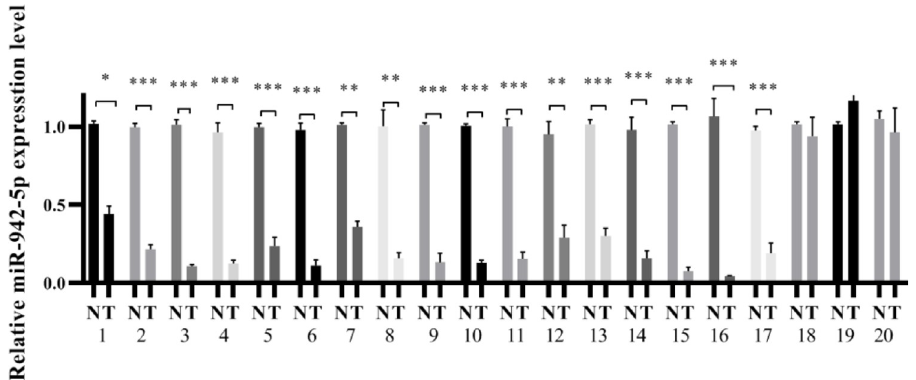
Fig 7. The expression of miR-942-5p in cancerous and paired paracancerous tissues of ESCC patients. ( � P < 0.05, �� P < 0.01, ��� P < 0.01).